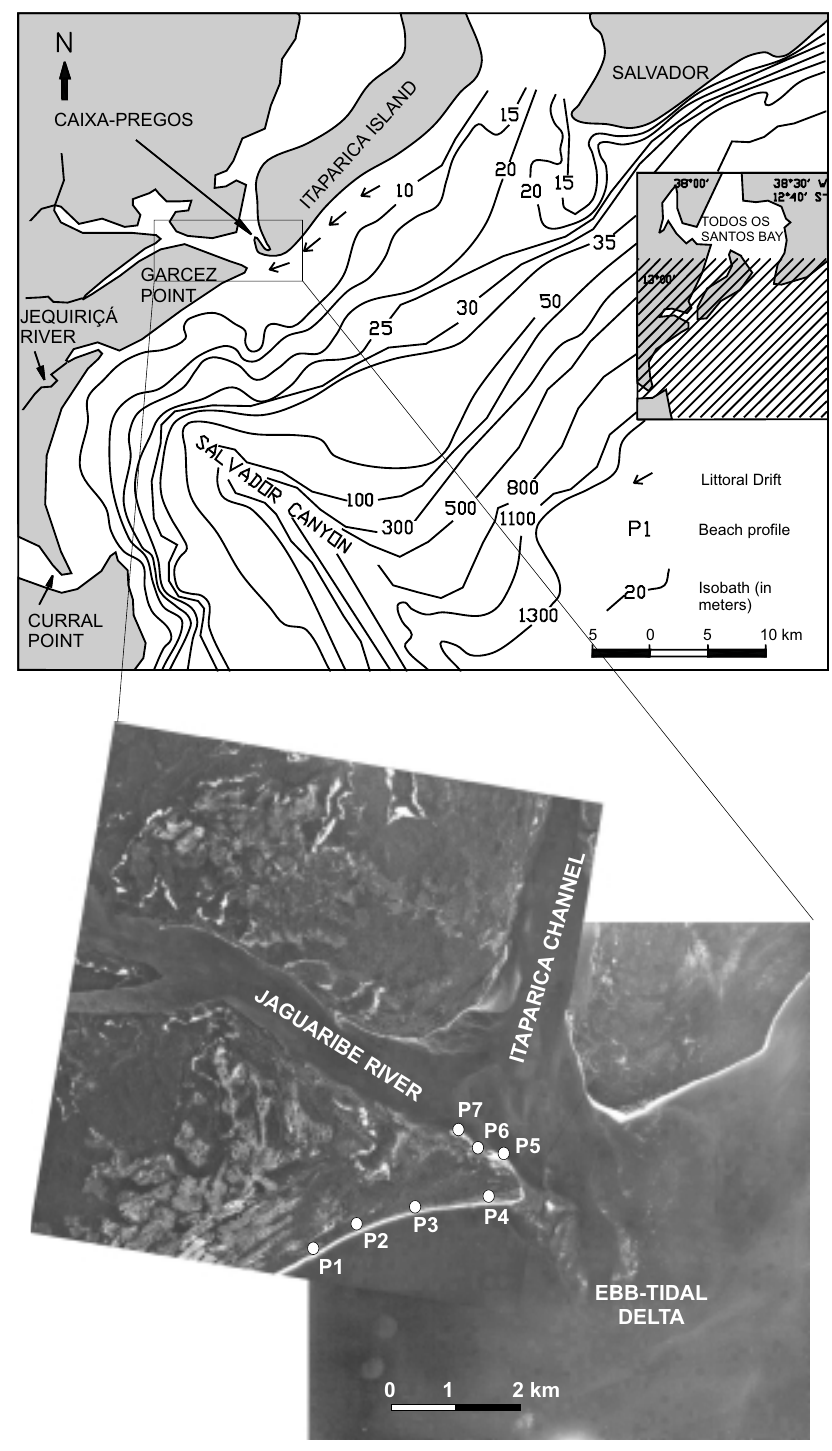
Fig. 1 – Location map of Garcez Point showing positions of the